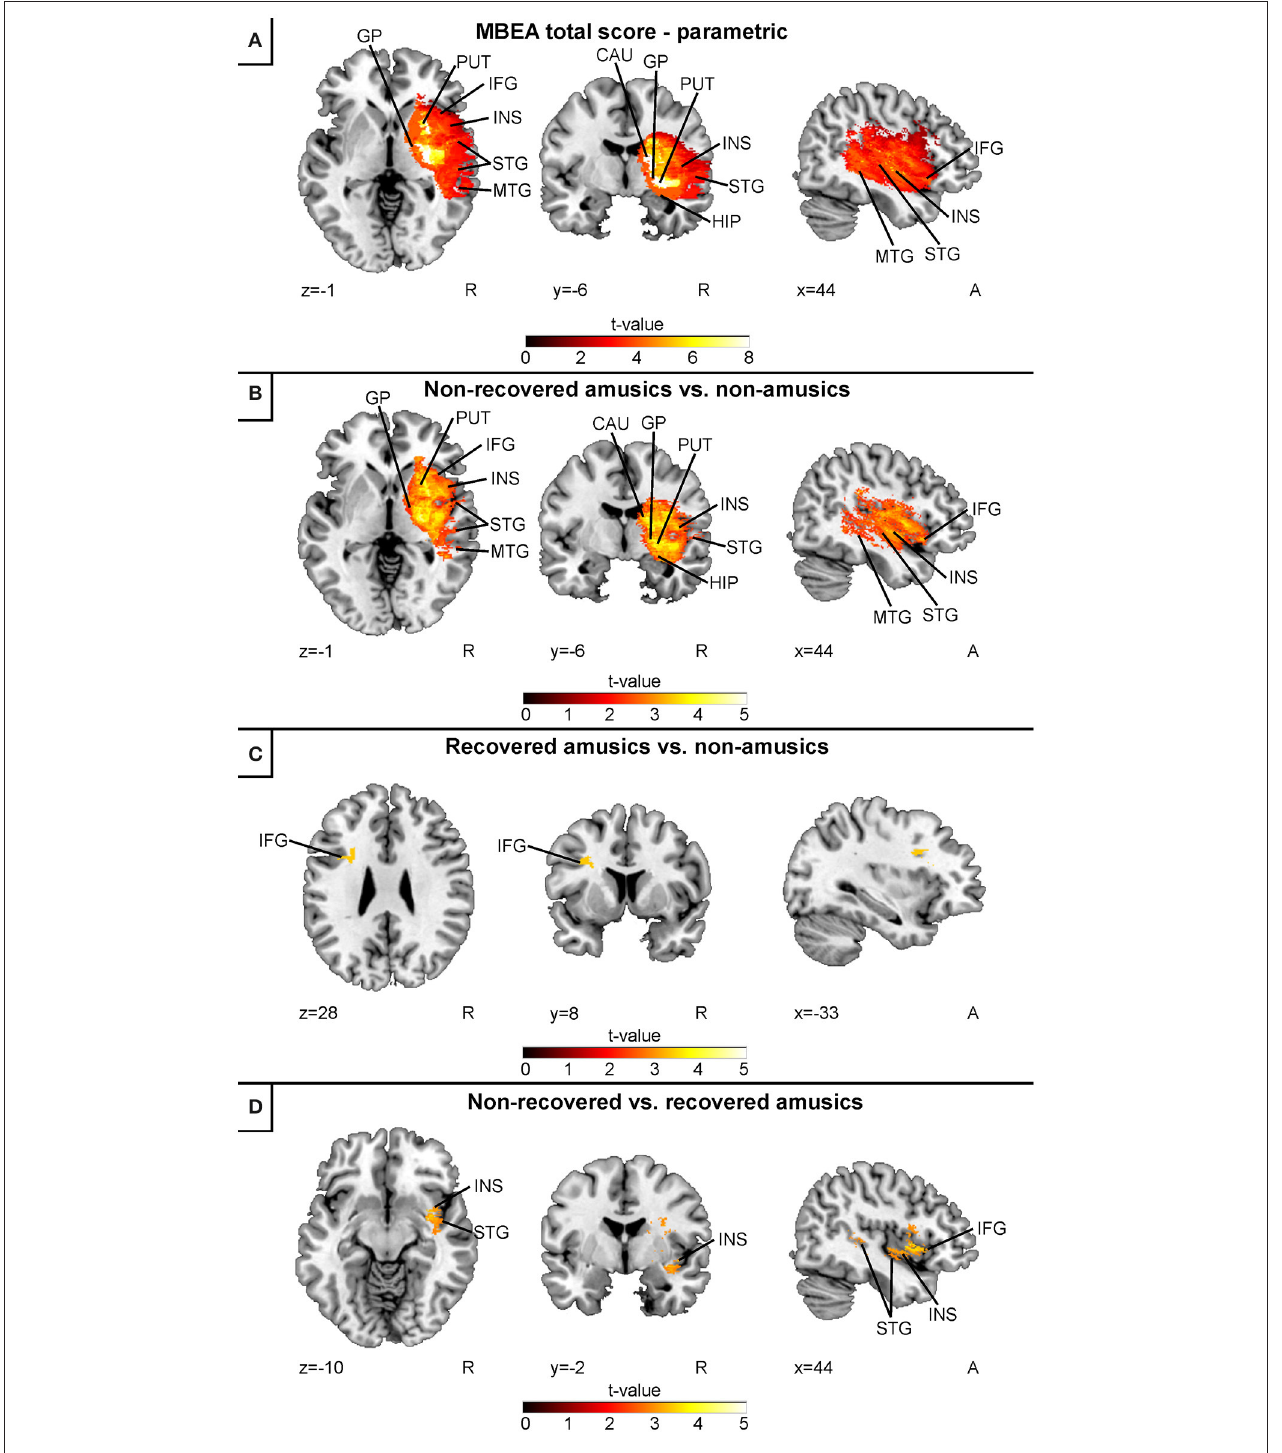
FIGURE 2 | Acute stage VLSM results for amusia: pooled analysis. (A) MBEA total score continuous analysis; (B) comparison between non-recovered amusic vs. non-amusic patients; (C) comparison between recovered vs. non-amusic patients; and (D) comparison between non-recovered vs. recovered amusic patients. Neurological convention is used with MNI coordinates at the bottom left of each slice. All statistical maps are thresholded at an FDR-corrected p < 0.05 threshold, except for the panel (D) , which is thresholded at uncorrected p = 0.005 ( t = 2.81). Critical brain structures are labeled. CAU, caudate; GP, globus pallidus; HIP, hippocampus; IFG, inferior frontal gyrus; INS, insula; MTG, middle temporal gyrus; PUT, putamen; STG, superior temporal gyrus.